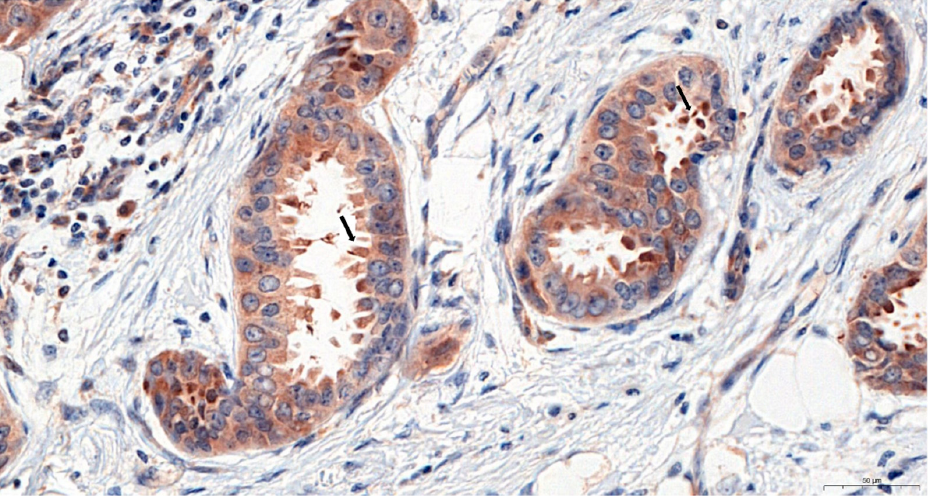
Figure 2. Positive immunohistochemical (IHC) reactions (brown color) indicating strong irisin expression in the apical parts of cancer cells and vesicles; magnification x400.